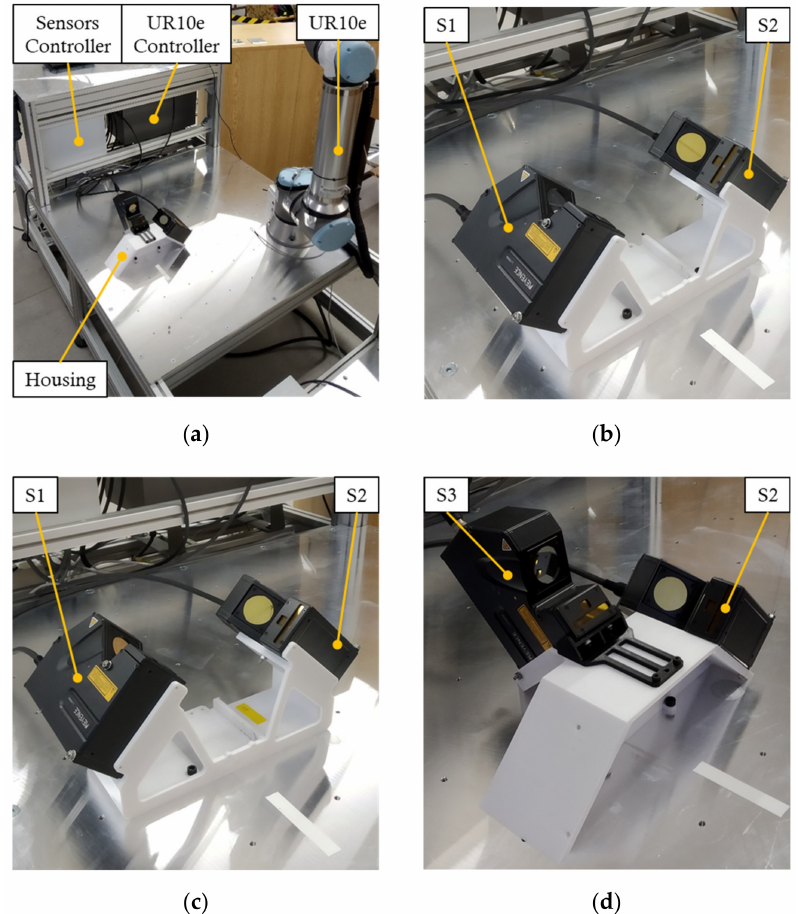
Figure 8. Experimental workplace and sensorics housings for all samples: ( a ) experimental workplace; ( b ) housing of Object A; ( c ) housing of object B; ( d ) housing of object